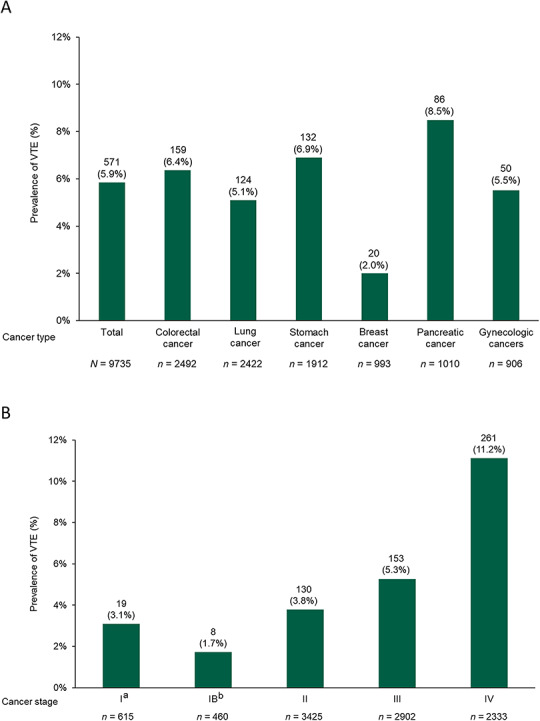
VTE prevalence by (A) cancer type and (B) cancer stage. aGynecologic cancer only. bLung cancer only. VTE, venous thromboembolism.